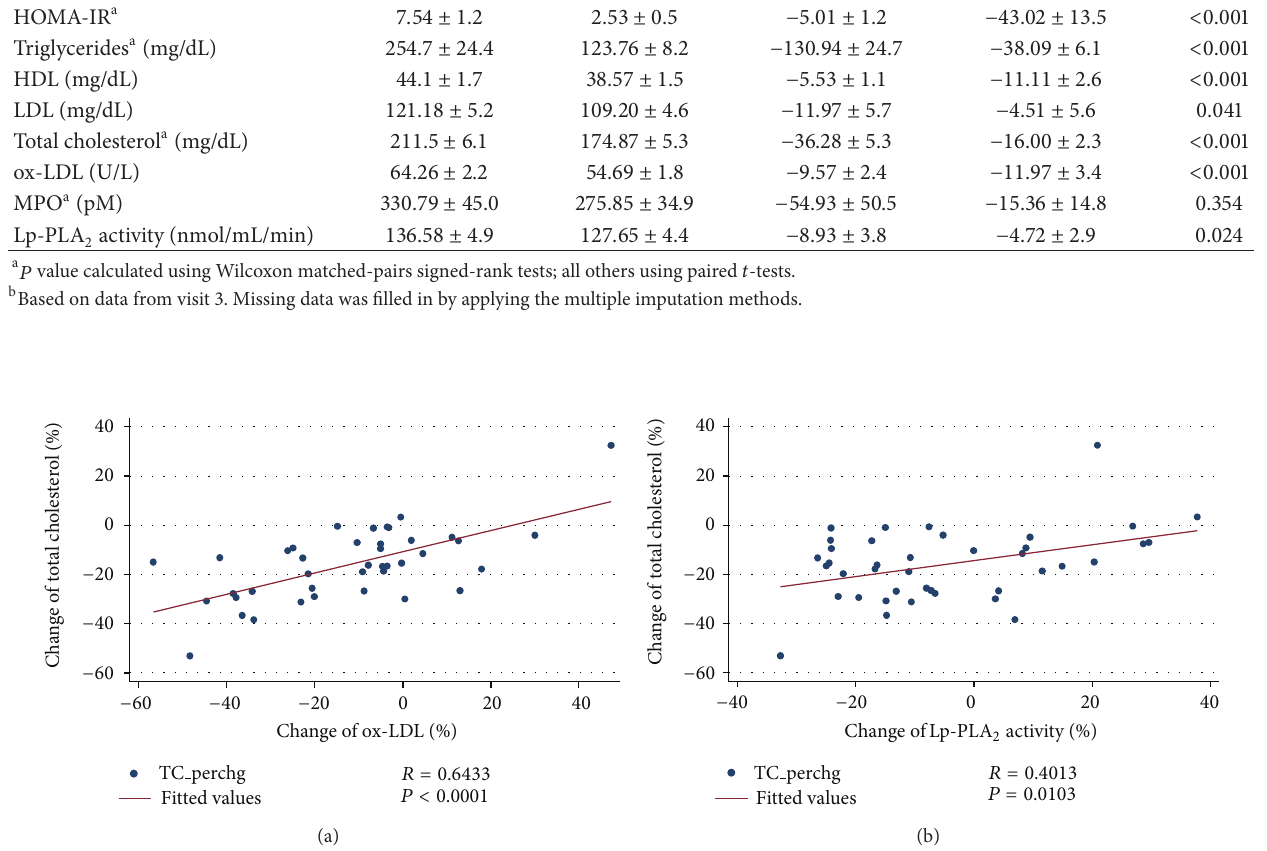
Figure 4: Percent change of total cholesterol versus percent change of ox-LDL and LpPLA 2 activity following rapid weight loss among obese men and women with the metabolic syndrome, Pearson’s correlation: (a) % change of total cholesterol versus % change of ox-LDL; (b) % change of total cholesterol versus % change of Lp-PLA 2